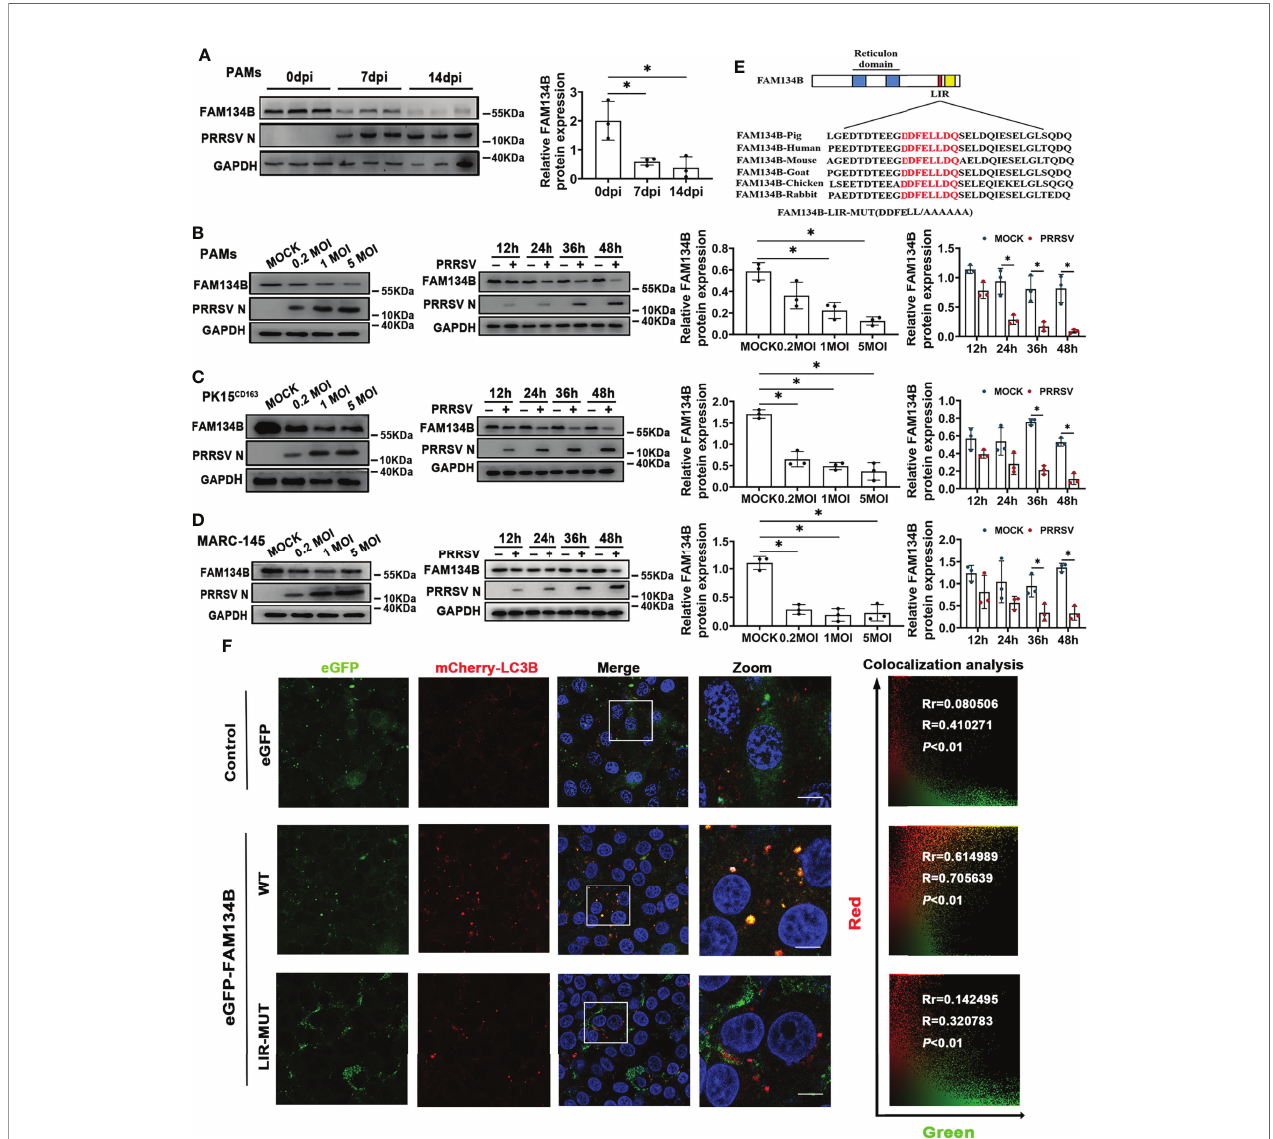
FIGURE 3 | PRRSV infection downregulates FAM134B protein expression. (A) Expression of FAM134B and PRRSV N protein in PAMs.. PAMs were collected from pigs infected with PRRSV (TCID 50 = 10 6 ) at 0 dpi, 7 dpi, and 14 dpi, respectively. * P <0.05, Kruskal Wallis test, n=3. (B – D) Expression of FAM134B and PRRSV N protein in PAMs (B) , PK15 CD163 cells (C) , and MARC-145 cells (D) . Cells were infected with different titers of PRRSV or at different time points, and these cells were subjected to immunoblotting assays. * P <0.05, Kruskal Wallis test, n=3. (E) Schematic representation of FAM134B protein domains. The amino acid DDFELL in FAM134B protein ’ s LIR domain bound by LC3 protein was mutated into AAAAAA for constructing FAM134B-LIR-MUT vector. (F) Representative confocal images of PK15 cells co-transfected with mCherry-LC3B (red) and empty vector (green), or eGFP-FAM134B (green), or eGFP-FAM134B-LIR-MUT (green). Pearson ’ s correlation (Rr) and Overlap coef fi cient (R) were calculated. Scale bars: 20 m m. T distribution was used to fi nd the P -value. GAPDH served as the control in immunoblotting